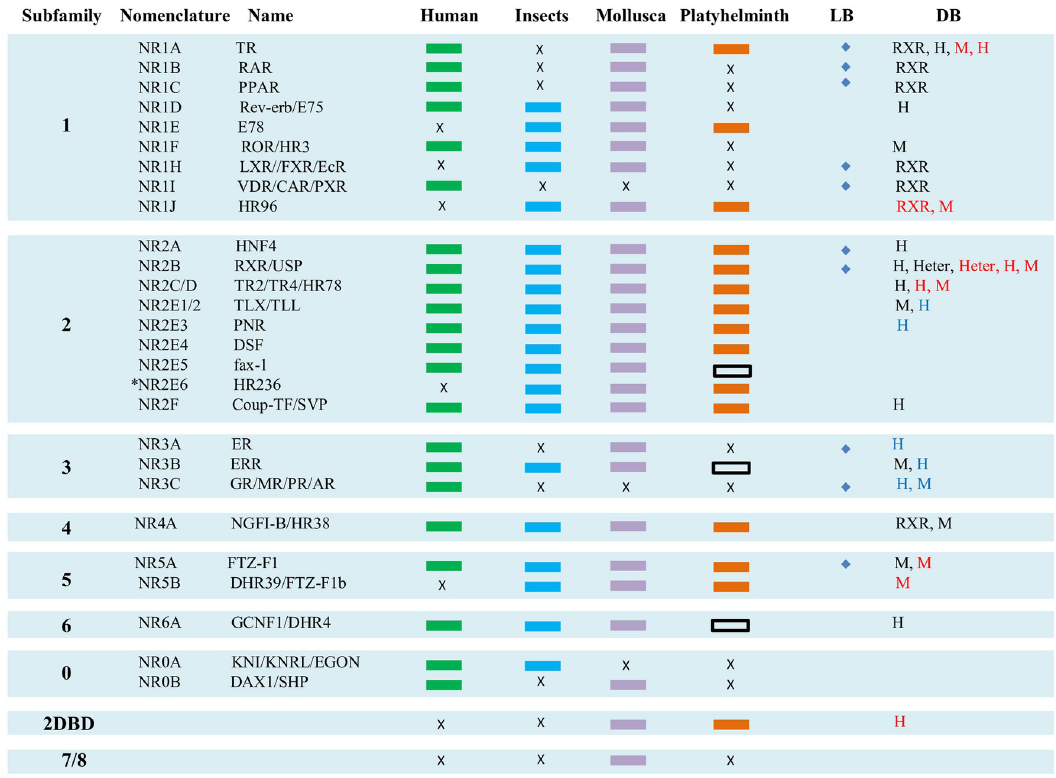
Fig 1. A schematic illustrates the different NR subfamilies and NRs in human, insects, Mollusca and Platyhelminths. Solid color box shows NRs in different animals, black box shows the new NRs found in Platyhelminths in this study and X indicates NRs loss in different animals. LB: Ligand binding, DB: DNA binding, diamond on ligand binding column indicates the NR was known to bind its ligand. On a DNA binding column, RXR indicates the NR can form a heterodimer with RXR, H: Homodimer, Heter: Heterodimer with other NRs, M: Monomer. On DNA binding column, the red character indicates DNA binding of Platyhelminth NRs studied in vitro [5, 6, 11, 16, 19–35].